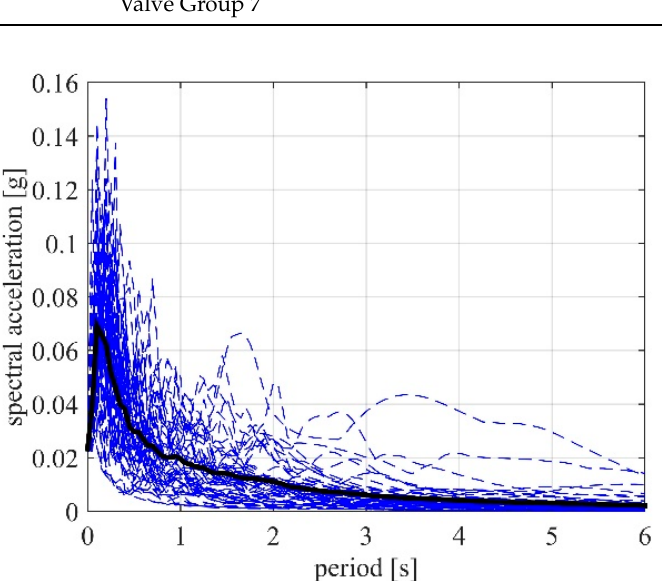
Figure 11. The response spectra (dashed lines) and average spectrum (bold solid line) of 59 scaled vertical ground motions (scaled PGA is 0.023 g).